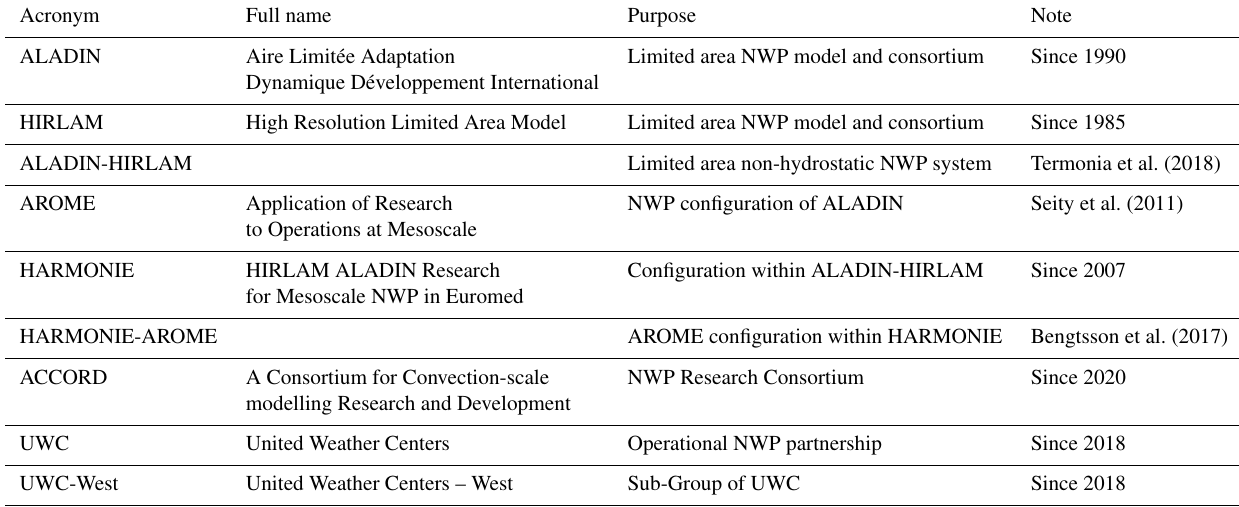
Table E1. Further Details on various NWP models, configurations and consortia mentioned in this